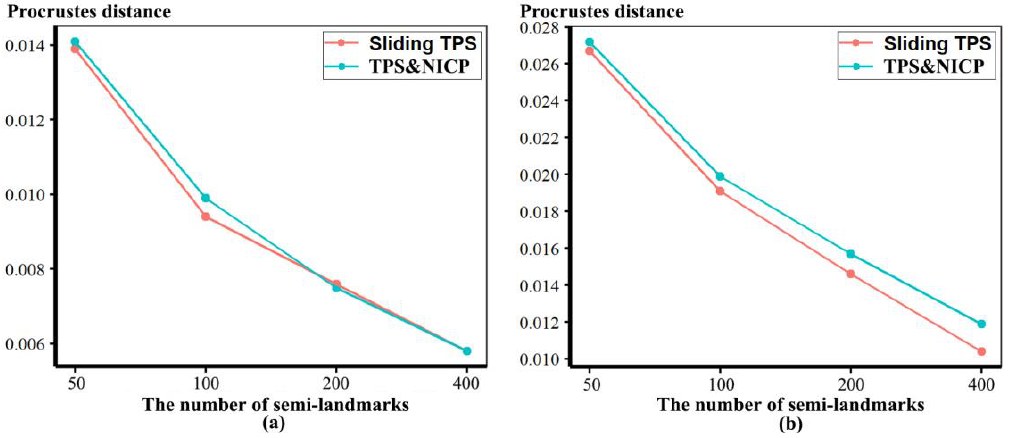
Figure 21. Procrustes distances, after re-semilandmarking and re-warping, between the allometrically scaled ape cranial surfaces derived from the maximum density and those from lower densities of semilandmarks. ( a ) Procrustes distances between predicted surfaces at the maximum centroid size. ( b ) Procrustes distances between predicted surfaces at the minimum centroid size.